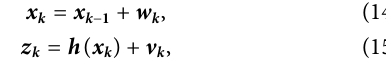
Frontiers in Robotics and AI |